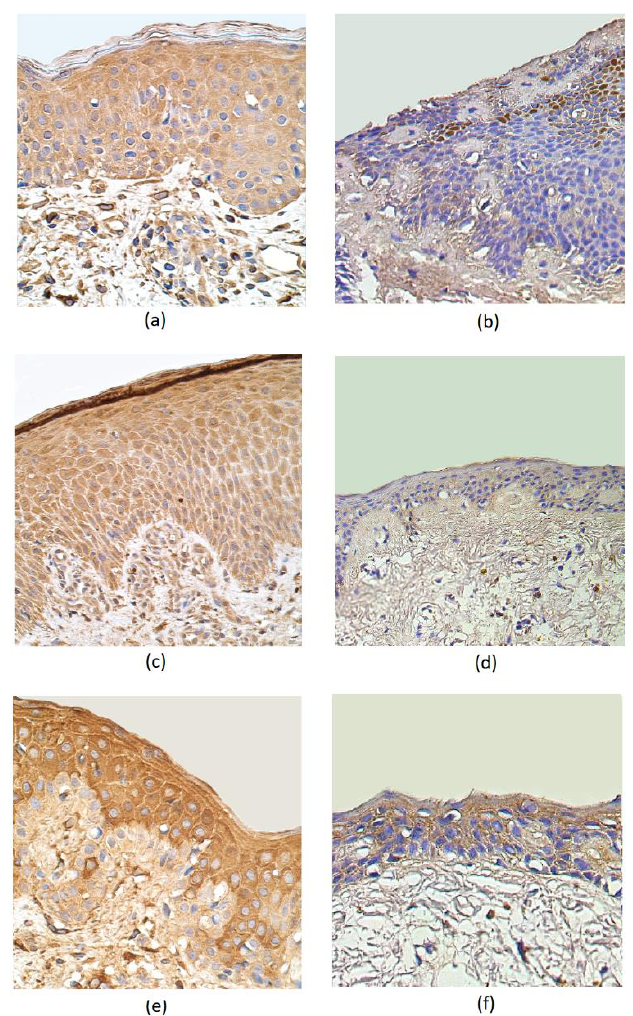
Figure 2. Immunohistochemical micrographs in rosacea-affected tissues and in control samples. ( a ) Moderate number of IL-1α-positive epitheliocytes and subepithelial cells in a 45-year-old female. IL-1α IMH, X 400; ( b ) occasional positive structures in epithelium and subepithelial connective tissue of control group in a 49-year-old male. IL-1α IMH, X 400; ( c ) moderate to numerous IL-10-containing epithelial cells and moderate immunoreactive cells in the connective tissue of a 44-year-old female. IL-10 IMH, X 250; ( d ) a few positive IL-10 structures in the epithelium and connective tissue of a 66-year-old male. IL-10 IMH, X 200; ( e ) moderate number of HBD-2-marked immunoreactive positive structures appearing in the epithelium and few to moderate in the subepithelium of a 35-year-old female. HBD-2 IMH, X 400; ( f ) moderate HBD-2-positive cells in the epithelium and a few positive structures in the connective tissue of a 66-year-old male. HBD-2 IMH, X 400.